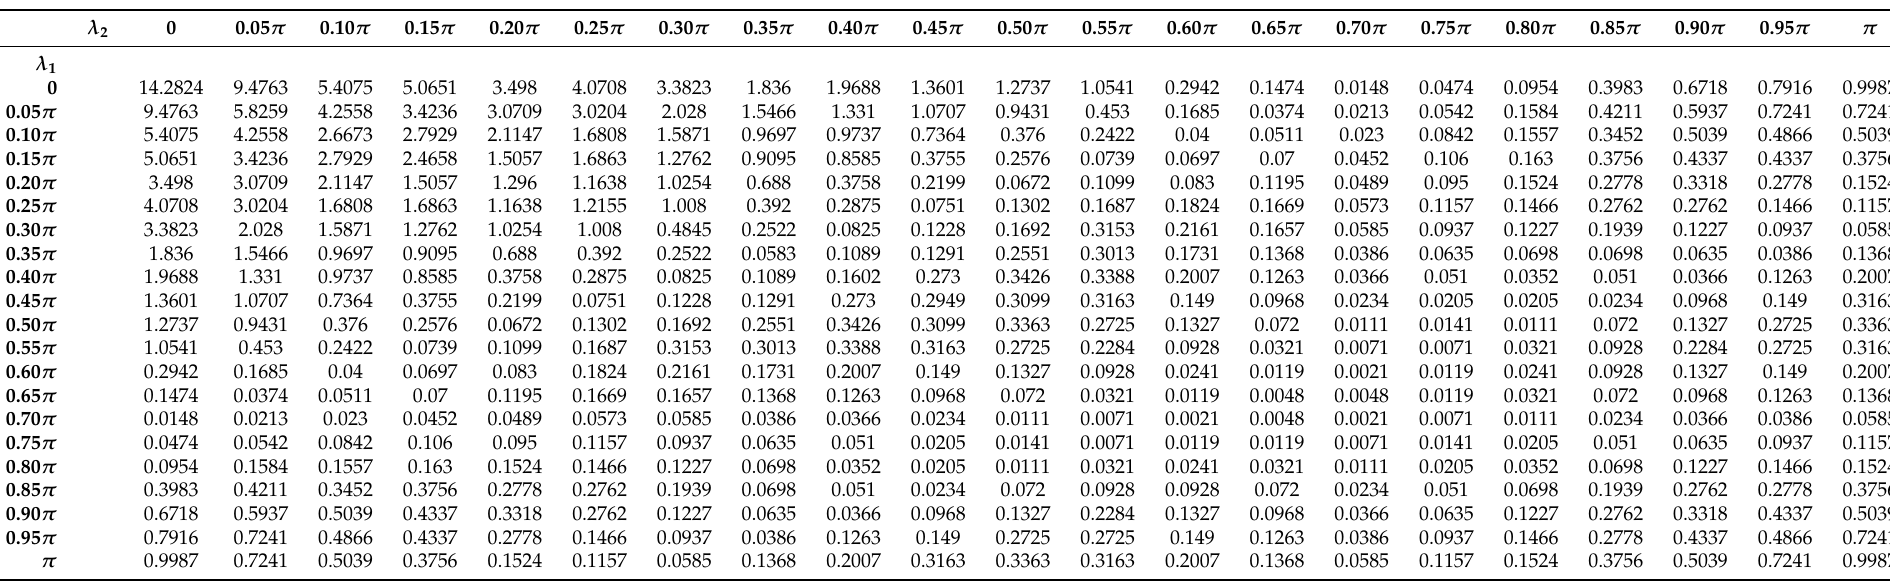
Table 7. Numerical values of smoothed multitapered biperiodogram of DCGINAR(1) model with M = 17 and β =